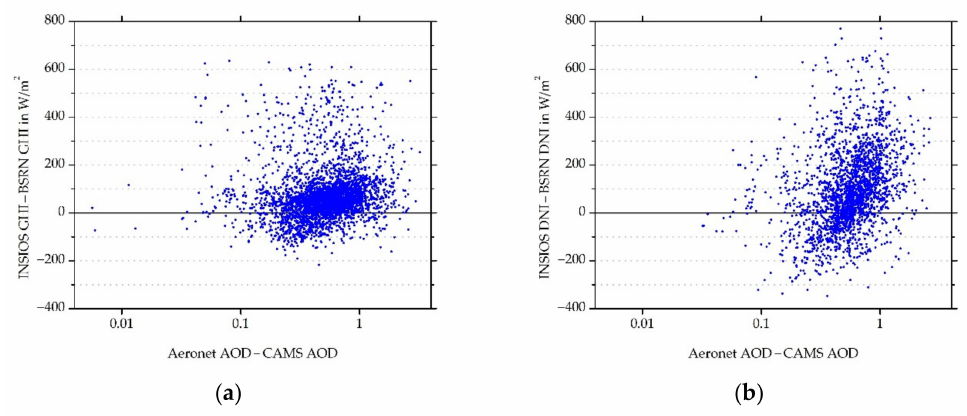
Figure 12. Absolute di ff erence in ( a ) GHI and ( b ) DNI (W / m 2 ) derived by INSIOS from BSRN data as a function of di ff erences in AOD from Aeronet and CAMS for all stations.